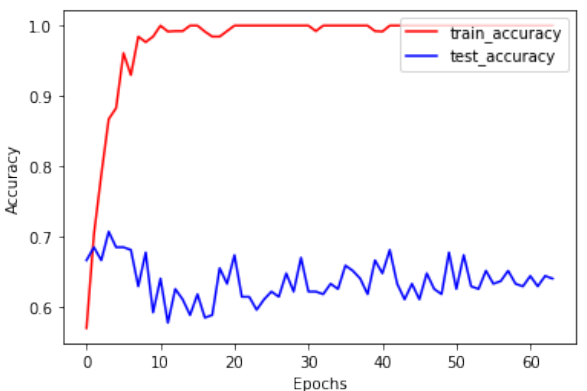
Figure 5. Comparison of prediction accuracies for train and test datasets on the CNN model for the air tire pressure fault.